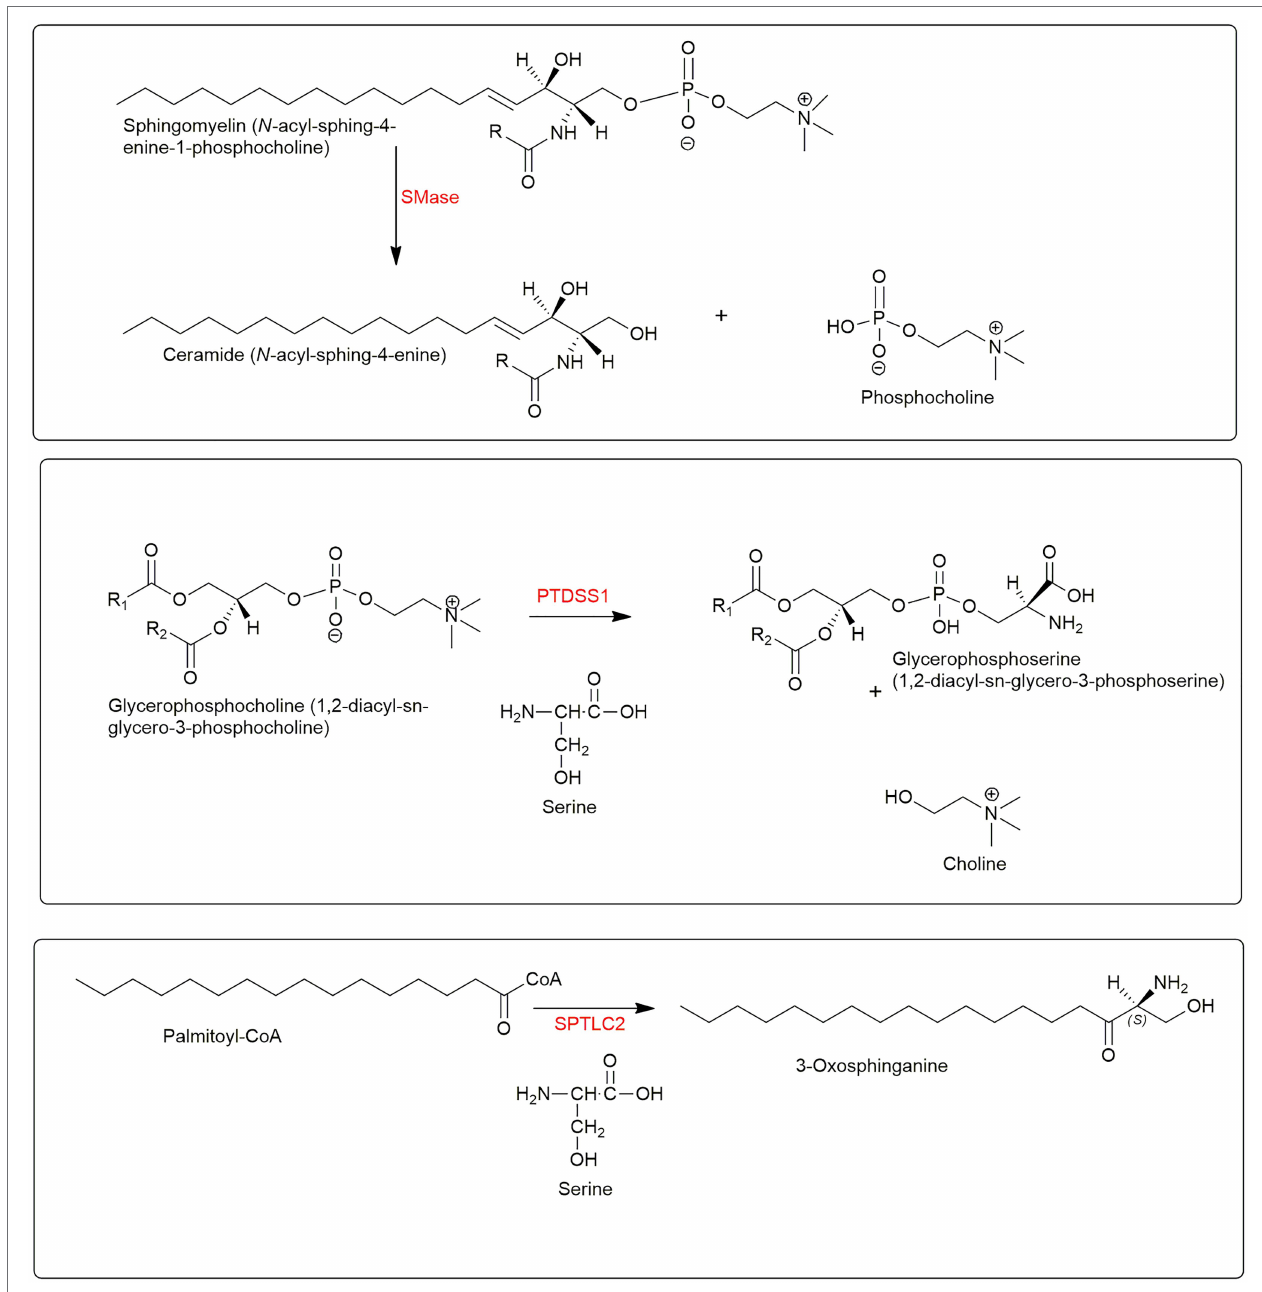
FIGURE 5 | Lipidomoics of accessible cholesterol. Upper panel , SMase hydrolyses SM to ceramide and phosphocholine. Central panel , PTDSS1 catalyses the conversion of PC to PS. Lower panel , SPTLC2 catalyses the formation of 3-oxosphinganine from palmitoyl-CoA and serine.